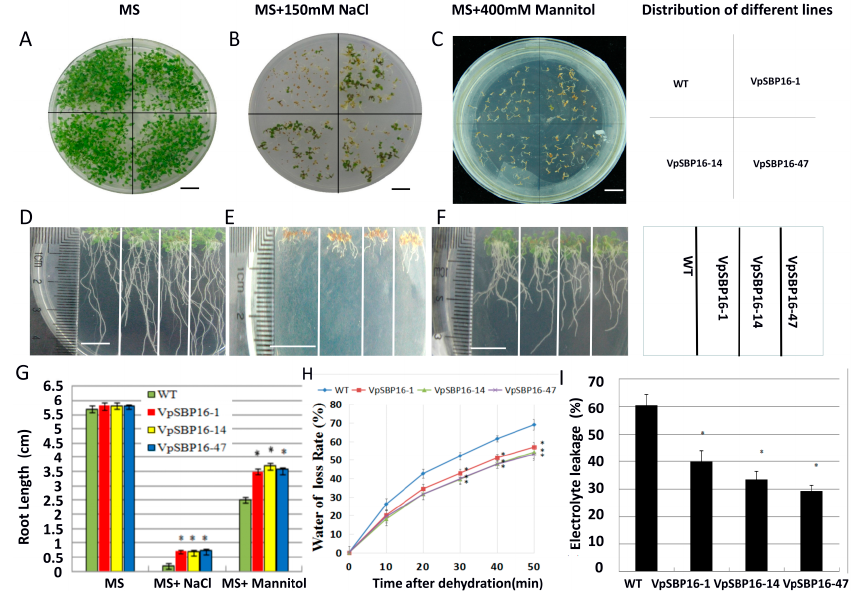
Figure 5. Analysis of the osmotic tolerance of WT and VpSBP16 transgenic A. thaliana seedlings. ( A – C ) Photographs of seedlings sown on MS basal medium, MS basal medium supplemented with 150 mM NaCl or 400 mM mannitol for 14, 35 and 20 days, respectively. The experiments were repeated three times with consistent results, scale bars: 1 cm. ( D – G ) Root growth ( D – F ) and root length ( G ) of WT and transgenic lines grown on MS basal medium, MS basal medium supplemented with 150 mM NaCl or 400 mM mannitol for 14, 35 and 20days, respectively. The experiments were repeated three times with consistent results, scale bars: 1 cm. ( H ) Water loss rate from 2-week-old detached transgenic and WT plants grown on the same MS basal medium, measured over a 50 min experimentation